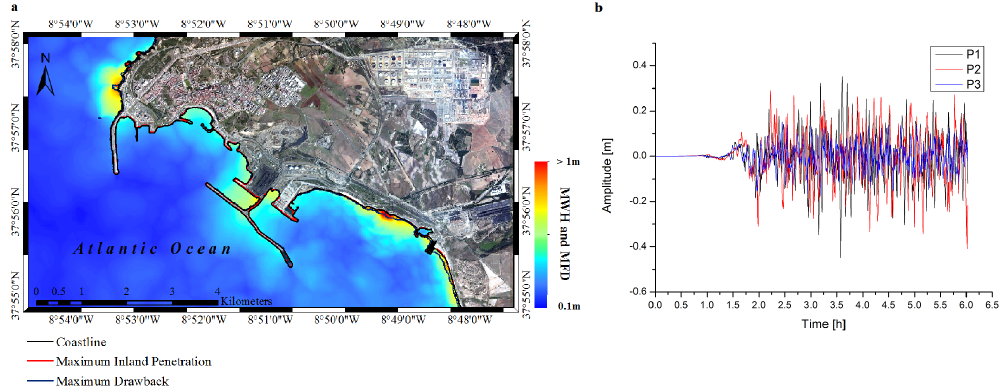
Figure 5. Panel (a) : results for MWH, MFD, MDB, MIA, and MIP for the Gloria scenario at MSL: MWH and MFD are represented by the colour bar offshore and on land respectively. Offshore and land are separated by the coastline (black line). MDB is indicated by the blue line. The MIA is given between the coastline and the MIP (red line). Panel (b) : synthetic waveform for 6h propagation time at three chosen points (cf. Fig. 2) for the Gloria scenario.